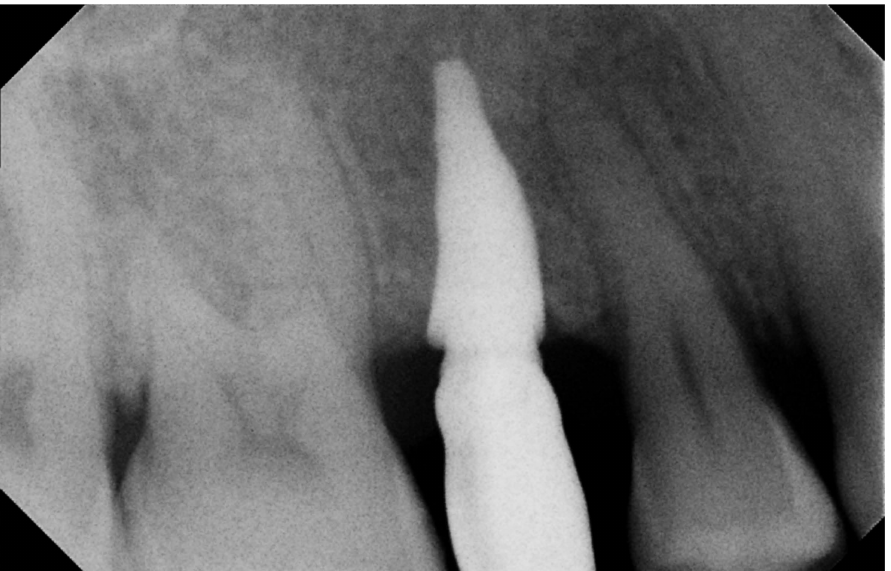
Figure 5. Five-year Rx follow-up. Rx check 5 years after implantation: the prosthetic crown was provisionally cemented to evaluate the clinical course over time (e.g., any infiltrations, etc.), the Rx image at the 5th year was captured after removing the crown to carry out the routine check established in the therapeutic plan, and so it was not present.